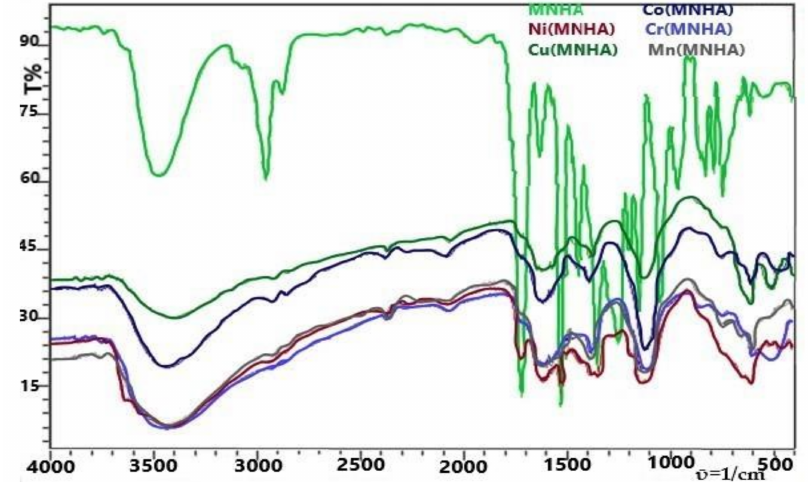
Figure 2. FT-IR experimental spectrum of methyl 2-((2-nitrophenyl)(hydroxyl)methyl) acry- late (MNHA).